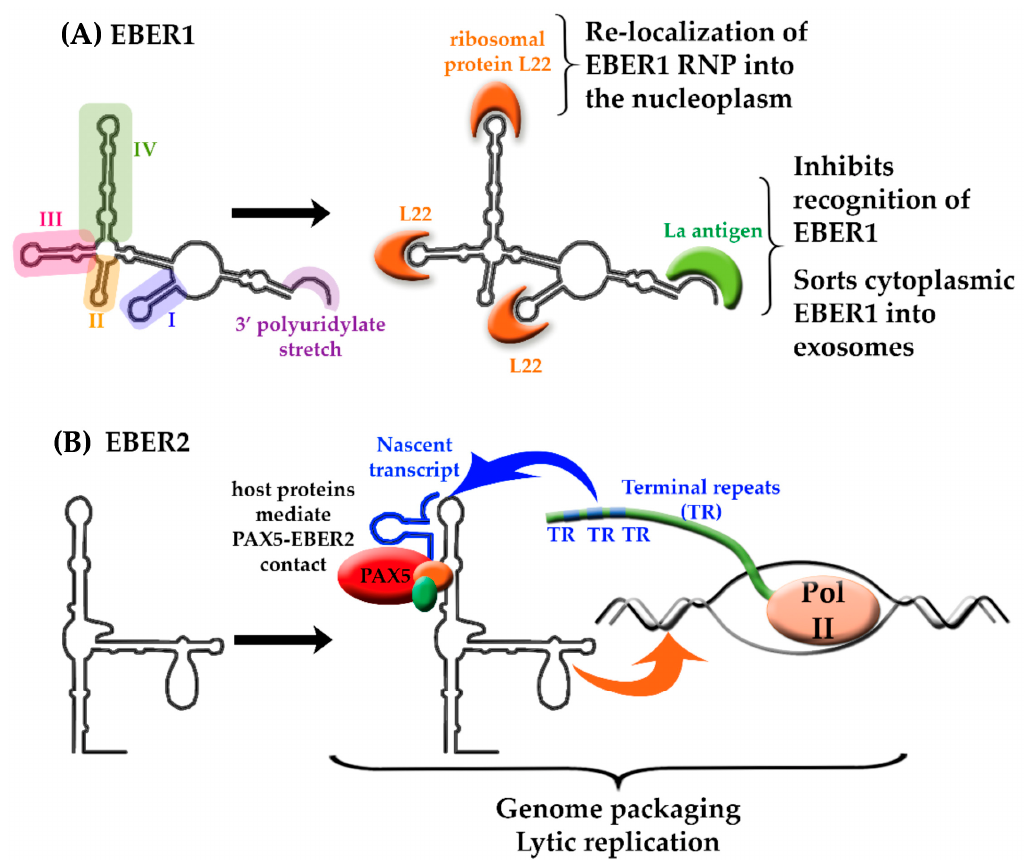
Figure 2. The structure-to-function relationship of EBER 1 and 2. ( A ) EBER 1 stem-loops I (violet), III (pink), and IV (green) create a scaffold for interaction with L22 (orange) resulting in the re-localization of EBER1:L22 into the nucleoplasm. EBER1 binds to the La protein (green) via the 3 ′ polyuridylate stretch (purple), shielding EBERs from recognition by host proteins; ( B ) EBER2 participates in the formation of a ternary complex with PAX5 (red), which involves host proteins (orange and green) and a nascent transcript (blue) expressed from the terminal repeats (TR) of the EBV genome. This interaction influences genome packaging and induces lytic gene expression, resulting in EBV reactivation.